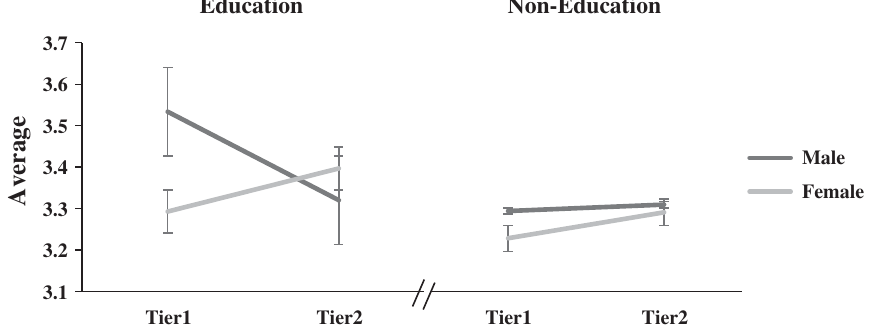
FIG. 1. Students ’ overall performances on the CLASS across different majors, genders, and university tiers.